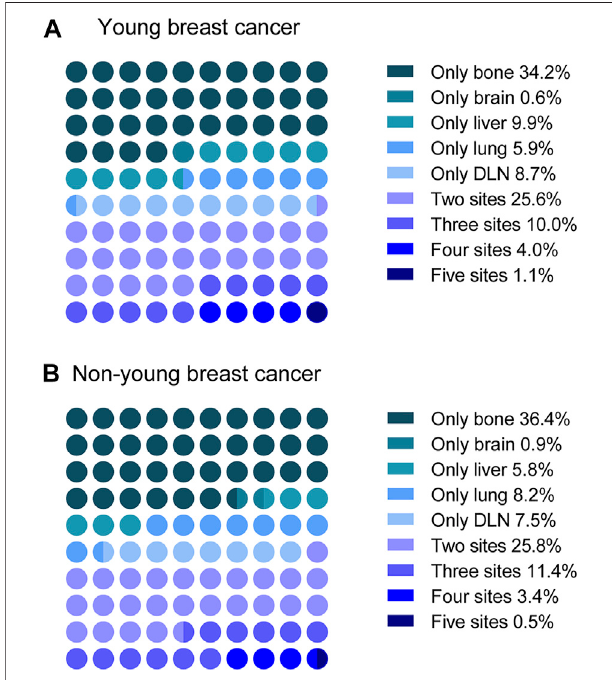
FIGURE 3 | Distribution of single-site metastasis and multisite metastases in (A) young and (B) non-young patients. DLN, distant lymph